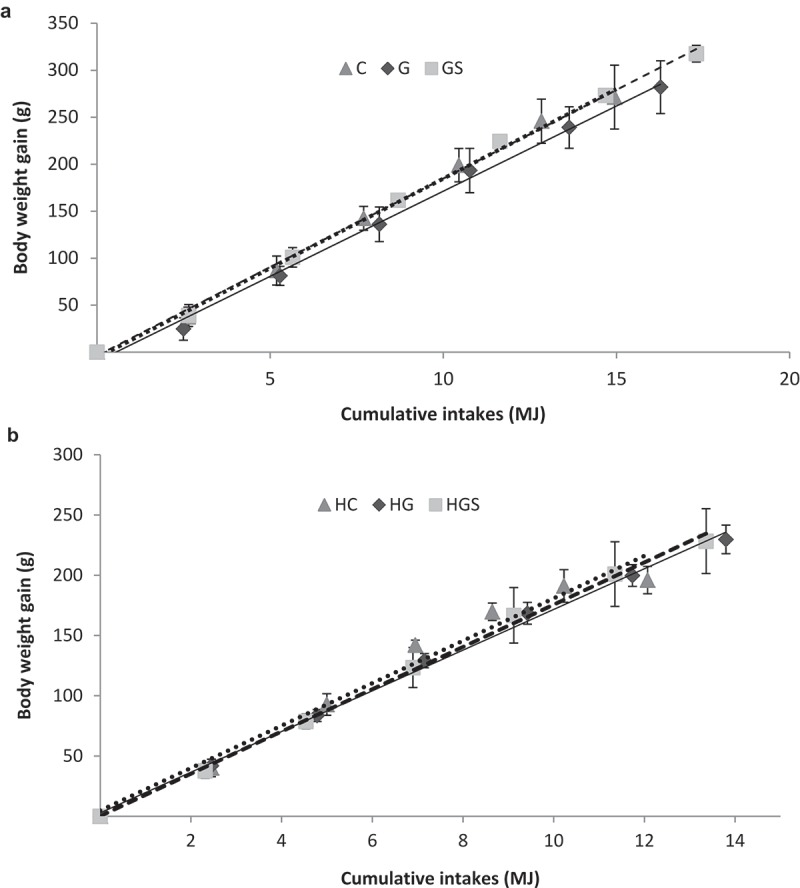
(a) Growth rates (body weight gain (g)/food consumption (MJ)) in rats fed the control, glucomannan- and glucomannan plus spirulina-enriched pork experimental diets. Y = (slope with their standard error) X + (intercept with their standard error). Where Y is the body weight gain and X is the food consumption. Control-RP (C): Y = (19.07 ± 3.38) X + (−5.94 ± 0.001); r
2 = 0.996 (p < 0.001); β = 0.998. Glucomannan-RP (G): Y = (18.13 ± 3.22)X + (−9.94 ± 0.001); r
2 = 0.995 (p < 0.001); β = 0.990. Glucomannan plus spirulina-RP: Y = (18.86 ± 1.76) X + (−3.73 ± 0.001); r
2 = 0.998 (p < 0.001); β = 0.998. Mean values were significantly different (ANCOVA test) for C vs. G. C vs. GS. and G vs. GS (all p < 0.05). (b) Growth rates in rats fed the control. Glucomannan- and glucomannan plus spirulina-RP experimental diets with supplementary cholesterol. Hypercholesterolemic control-RP (HC): Y = (17.62 ± 3.28) X + (4.69 ± 0.001); r
2 = 0.973 (p < 0.001); β = 0.987. Hypercholesterolemic glucomannan-RP (HG): Y = (16.88 ± 2.01) X + (2.77 ± 0.001); r
2 = 0.997 (p < 0.001); β = 0.995. Hypercholesterolemic glucomannan plus spirulina-RP (HGS): Y = (17.54 ± 2.94) X + (0.15 ± 0.001); r
2 = 0.998 (p < 0.001); β = 0.989. Mean values were significantly different (ANCOVA test) for HC vs. HG and HC vs. HGS (both p < 0.05). RP: restructured pork.